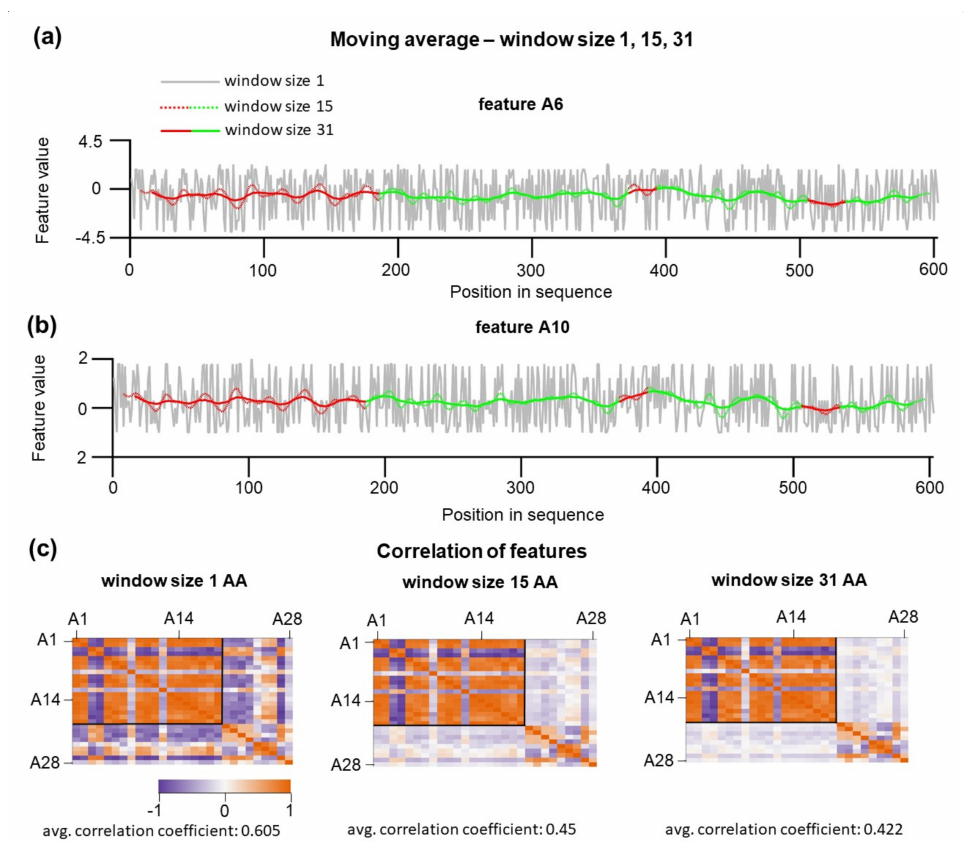
Figure 3. Effect of three different moving average window sizes (1 amino acid (aa), 15 aa, 31 aa) on feature values. ( a , b ) Effect of window size 1 aa (grey line), window size 15 aa (red/green dotted line), and window size 31 aa (red/green full line) on feature A6 and feature A10 values along the E. coli DnaK sequence. ( c ) Heat maps showing correlations between features as a function of different window sizes. Features A20 to A28 characterize the physio-chemical state of a single aa. Their values and pairwise correlations do not change with window size. Average correlation coefficients are shown bellows the heat maps. These correlations are the largest between the features at 1 window size, and the pairwise correlations decrease as the window size